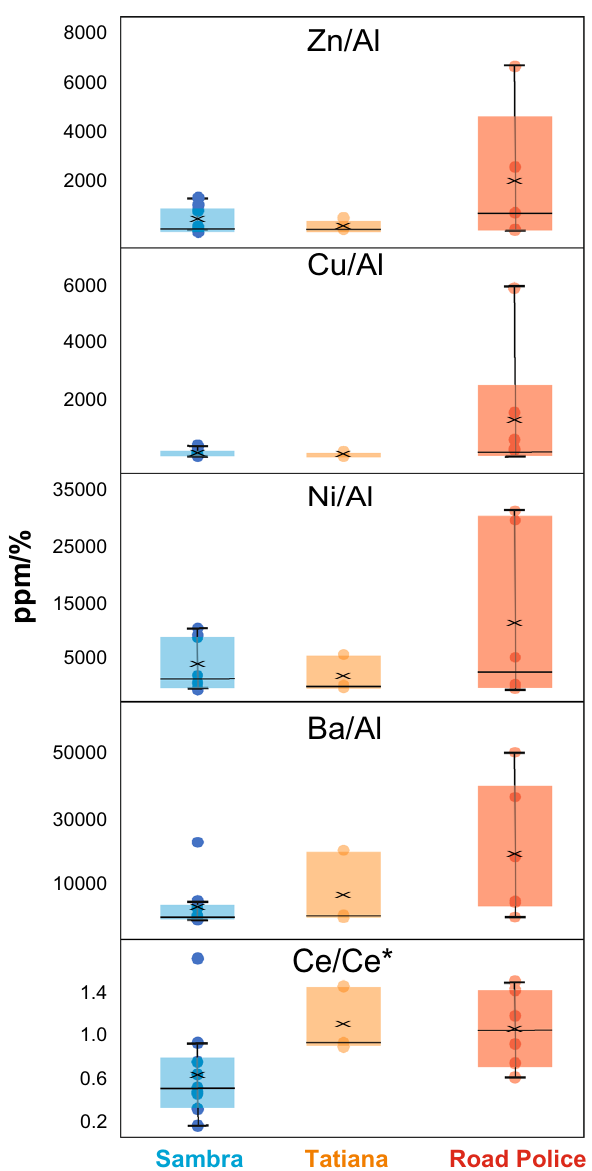
Figure 4. Box–Whisker plots showing the variation of trace metal contents and Ce anomalies for each studied section. Charts were created using Microsoft Excel (http:// www. micro soft. com) and Corel Draw Graphics Suite 2018 (http:// www. corel draw.